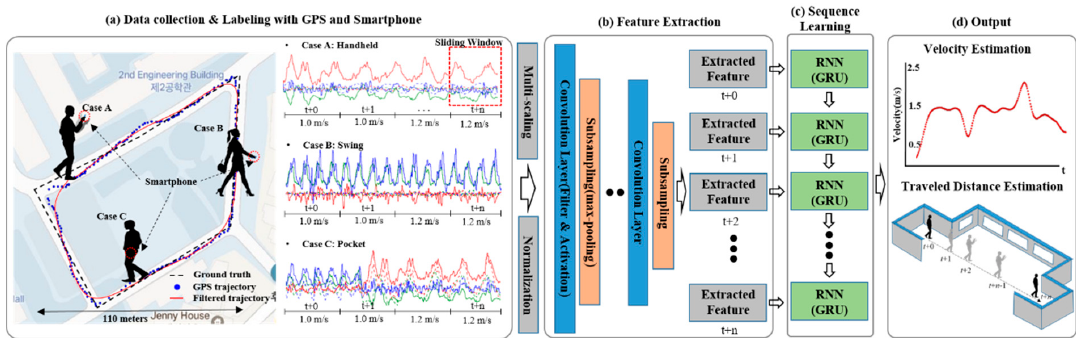
Figure 1. An overview of our indoor localization system using a proposed outdoor walking pattern learning scheme. ( a ) Inertial measurement unit (IMU) signal and velocity mapping using global position service (GPS)-based user trajectory by walking pattern at outdoor. The collected dataset is used as training data to the following proposed deep learning model; ( b ) Hybrid CNN–RNN deep learning model. The nonlinear features of the training data were automatically extracted using the multiple convolutional layers with activation and pooling layers; ( c ) The RNN uses the extracted feature vector at each time step as an input, and learns using signal patterns and labeled velocities; ( d ) The pedestrian’s average velocity at each time step and the cumulative traveled distance using the learned deep learning model parameters are estimated when moved